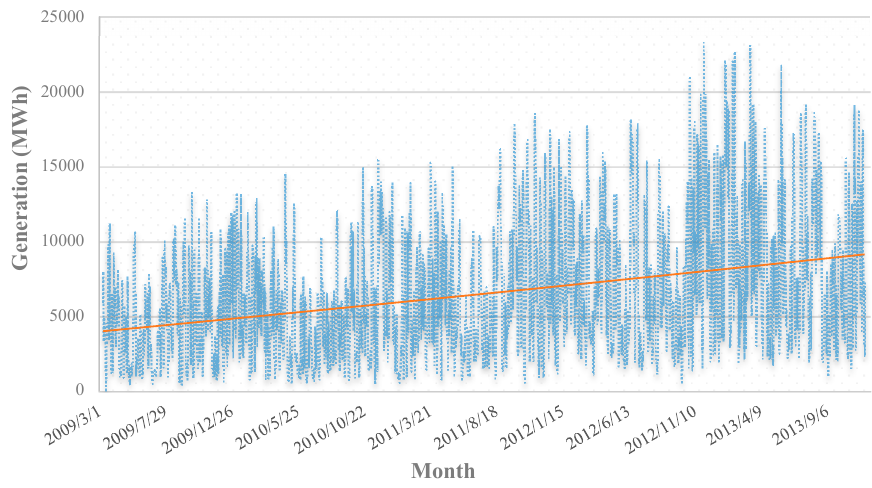
Figure 5. Daily wind power generation in Greece during the period March 2009 to November 2013 (data as acquired from [48]).